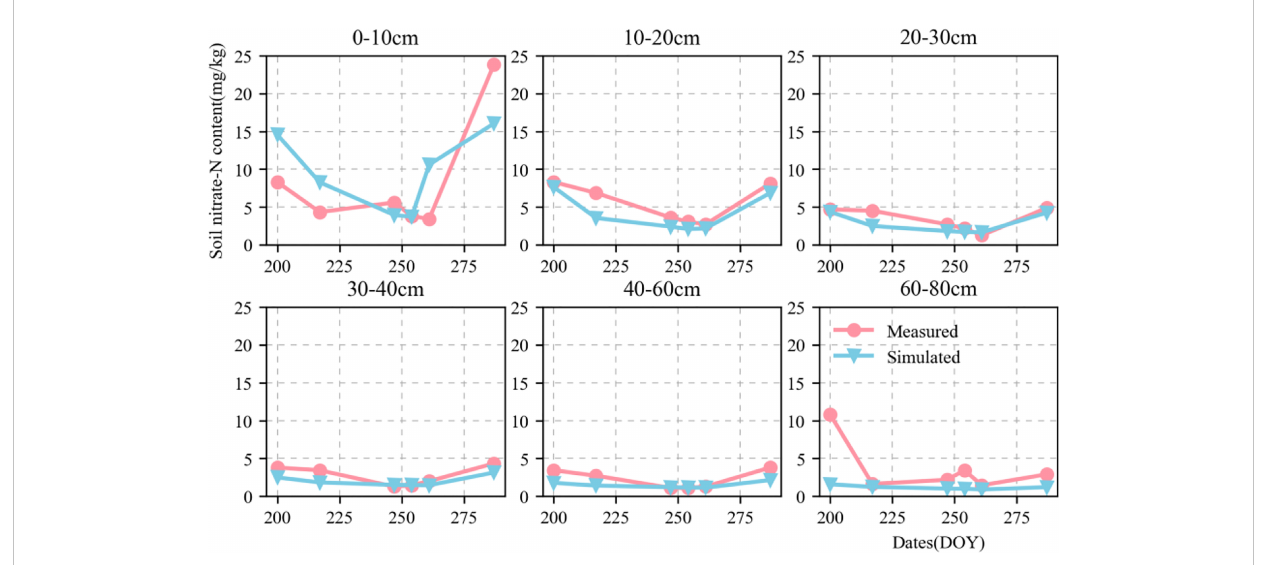
FIGURE 7 Dynamics of simulated (blue triangle) and measured (red circle) soil nitrate content value in 0 – 80-cm soil pro fi le at Xinxiang site from 2018 to